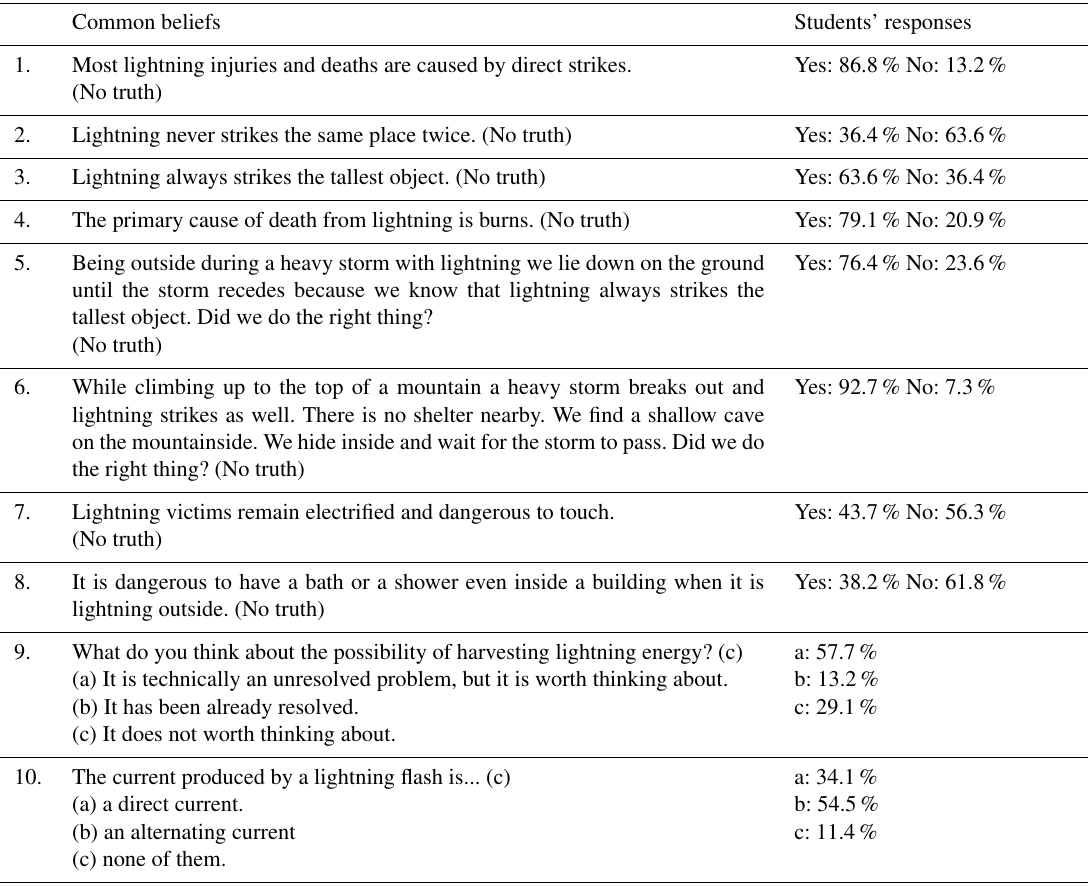
Table 2. Common beliefs and students’ responses. Common beliefs